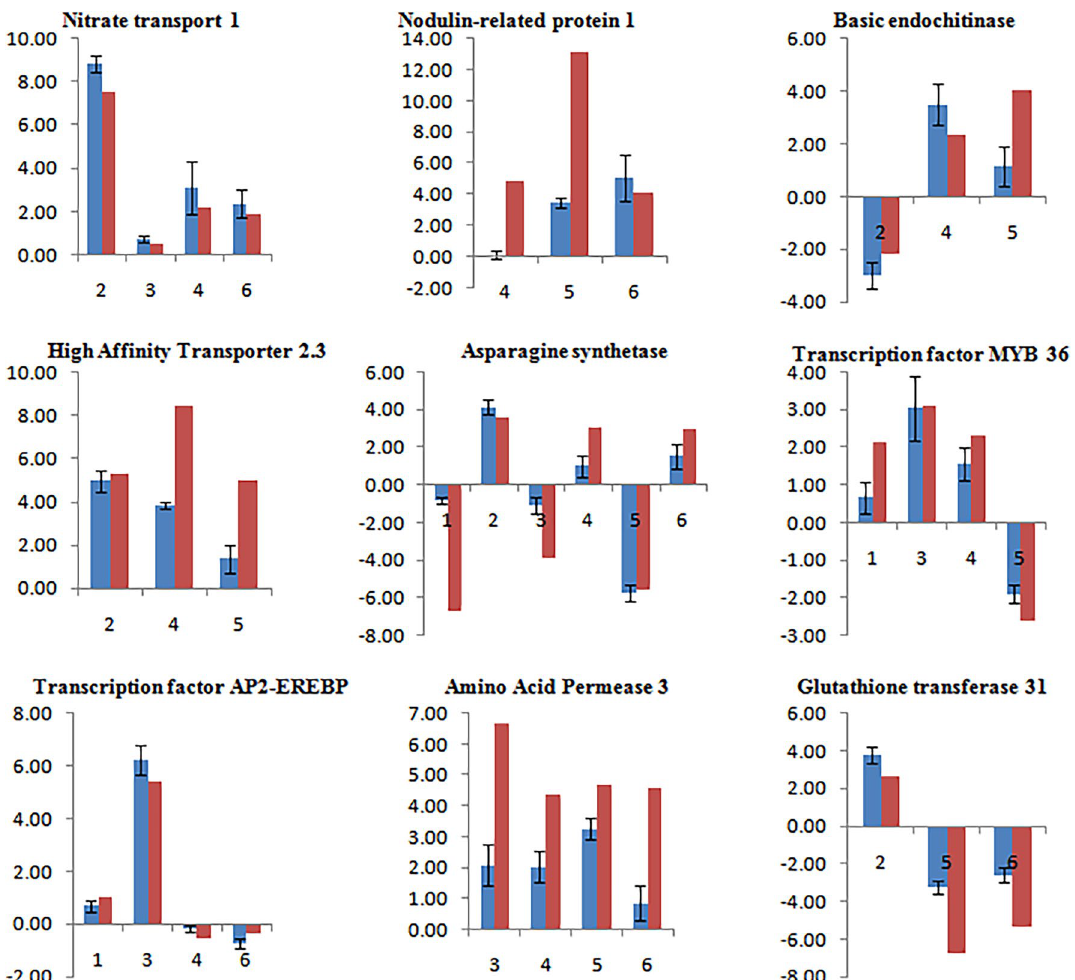
Figure 10. Comparison of expression analysis of selected nitrogen stress-responsive genes via qRT-PCR (represented by blue colour) and NGS approach (represented by red colour) in maize inbreds, viz., DMI 56 (tolerant to nitrogen stress) and DMI 81 (susceptible to nitrogen stress) in response to nitrogen stress treatment. 1–6 numbers on X -axis represent comparisons in which a particular gene has significant expression. 1–6 corresponds to DMI 81_SN+ v/s DMI 81_SN−, DMI 81_RN+ v/s DMI 81_RN−, DMI 56_SN+ v/s DMI 56_SN−, DMI 56_RN+ v/s DMI 56_RN−, DMI 56_SN− v/s DMI 81_SN− and DMI 56_RN− v/s DMI 81_RN−, respectively. Letter S, R, N+, and N− represents leaf, root, sufficient nitrogen, and nitrogen-deficiency conditions respectively. Y -axis represents the log2 fold change in expression Putative transposase, FIP1 protein (Zm00001d013380) (Table 4). Nodulin-related protein is expressed in Arabi- dopsis plant parts in all developmental stages and modulated by external environmental cues 63 . Leucine-rich repeats kinases are the largest subgroup of the RLK family with 309 members in rice and 235 members in Arabi- dopsis and have a very important role in plant response to abiotic stress 64–66 . Similarly, Cysteine-rich receptor-like protein kinases has been shown to be up-regulated under N-deficiency stress in rice 41 . In our study, transposases